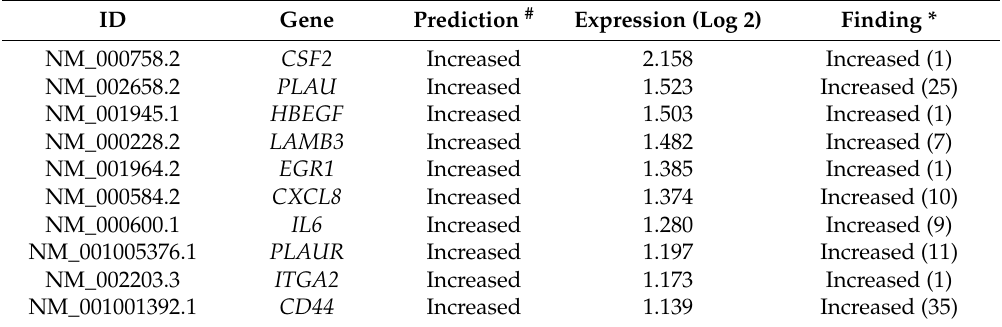
Table 2. Top 10 upregulated migration-related candidate genes in cells with long-term Oro-A